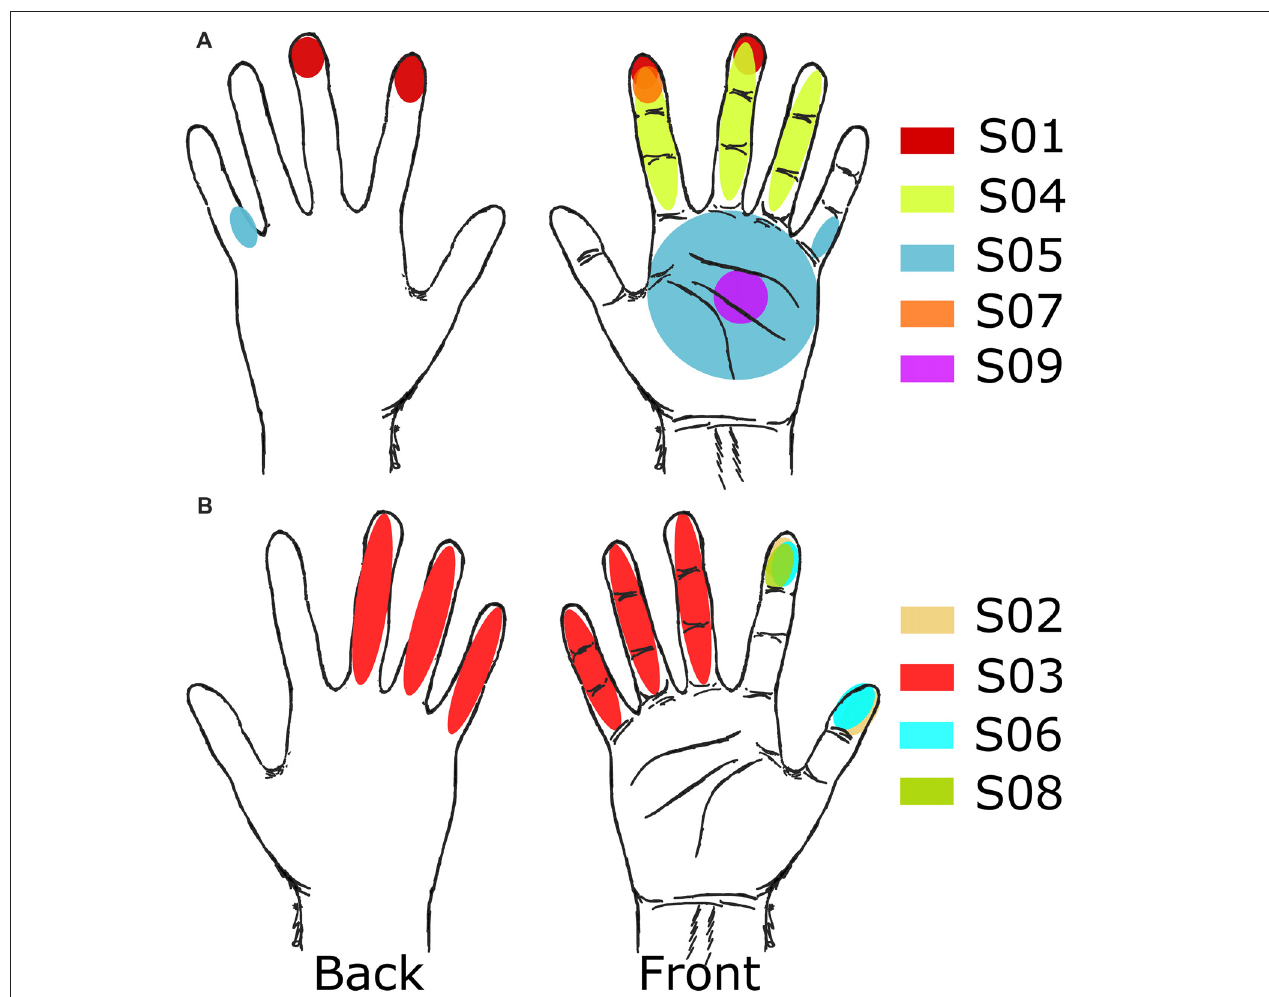
FIGURE 4 | Receptive fields from grid mapping. Selected receptive fields after grid mapping for all subjects. (A) Subjects with right side implants. (B) Subjects with left side